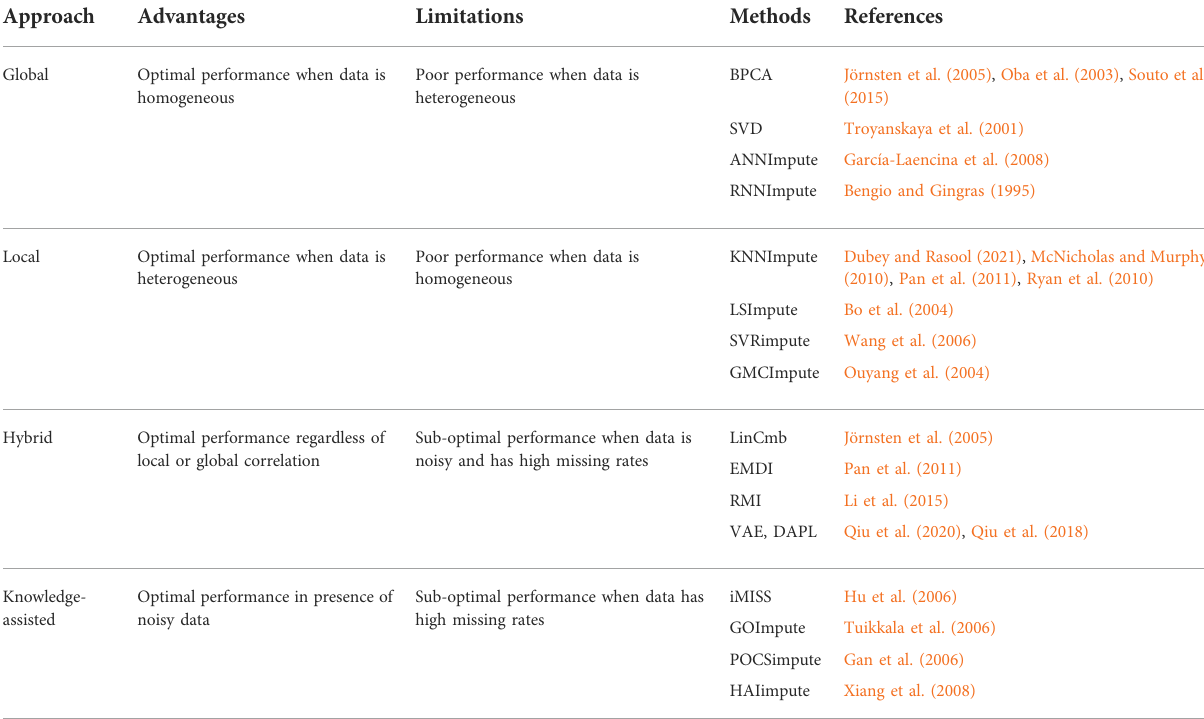
TABLE 2 Various approaches of missing value